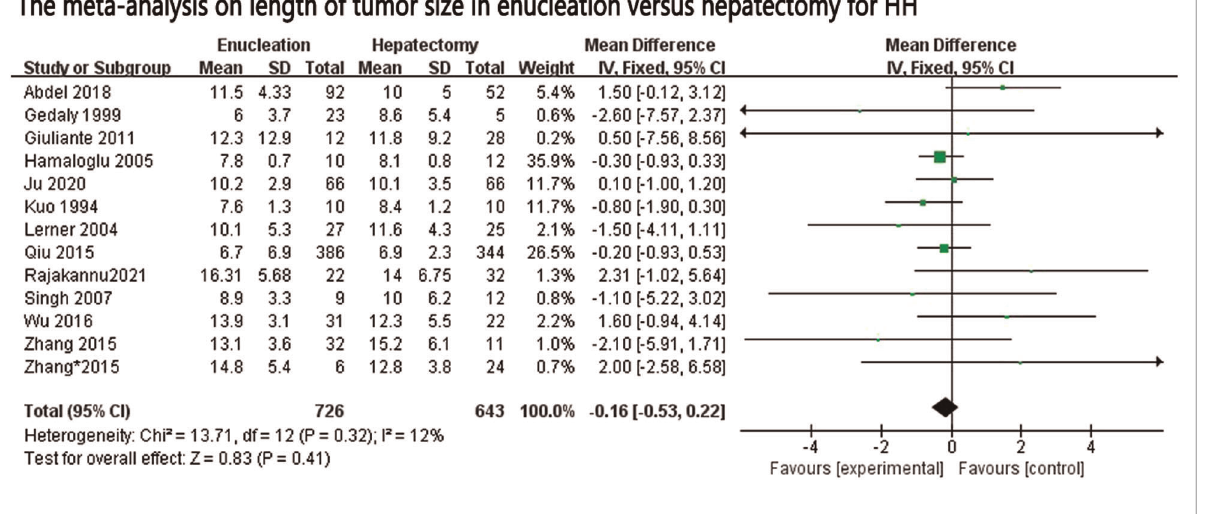
FIGURE 4 The forest plot for tumor size in enucleation versus hepatectomy for